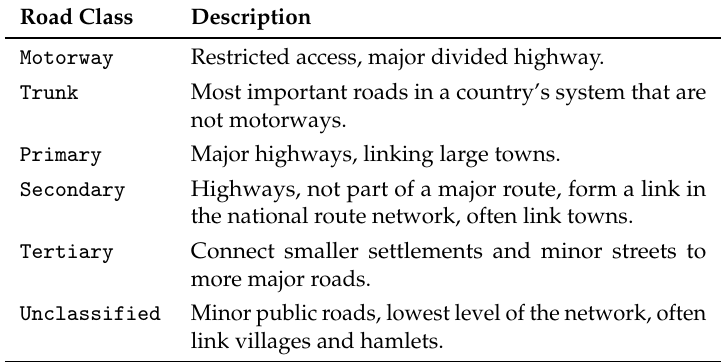
Table 1. Road classes in the OSM road network, taken from [18]. Road Class Description Motorway Restricted access, major divided highway. Trunk Most important roads in a country’s system that are not motorways. Major highways, linking large towns. the national route network, often link towns. more major